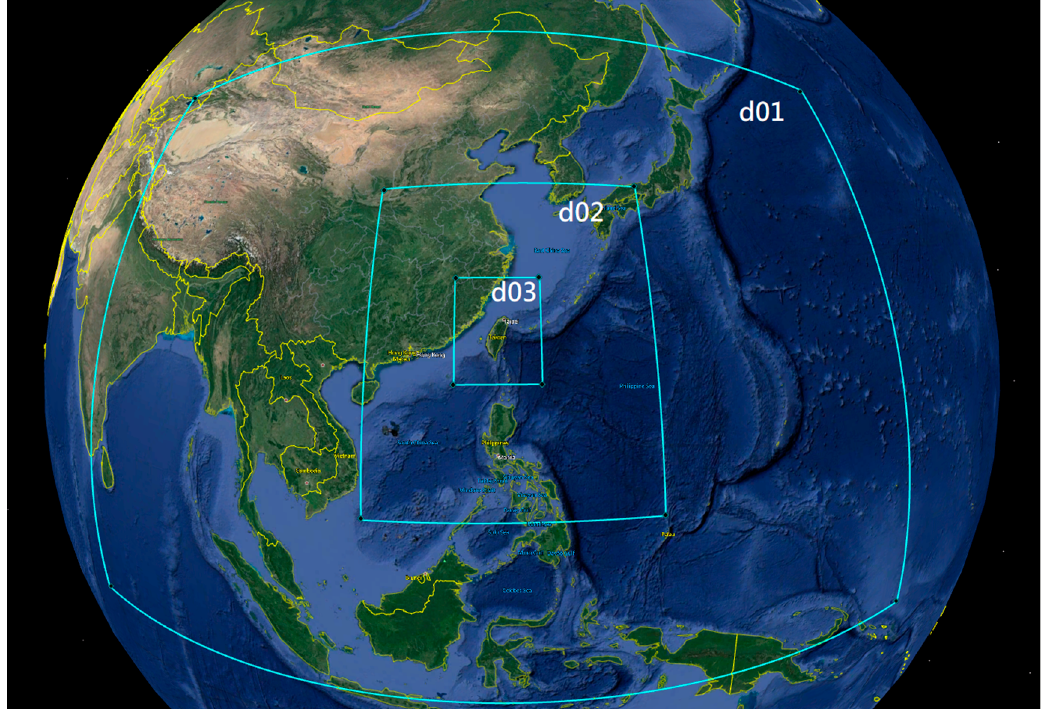
Figure 4. The extents in the WRF model for Domain 1 (d01) with a grid spacing of approximately 45 km, Domain 2 (d02) with a grid spacing of approximately 15 km, and Domain 3 (d03) with a grid spacing of approximately 5 km.